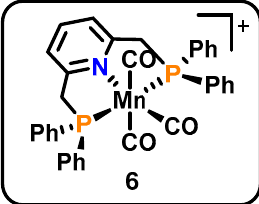
Figure 3. Structure of the PNP Mn pincer catalyst 6 [48].